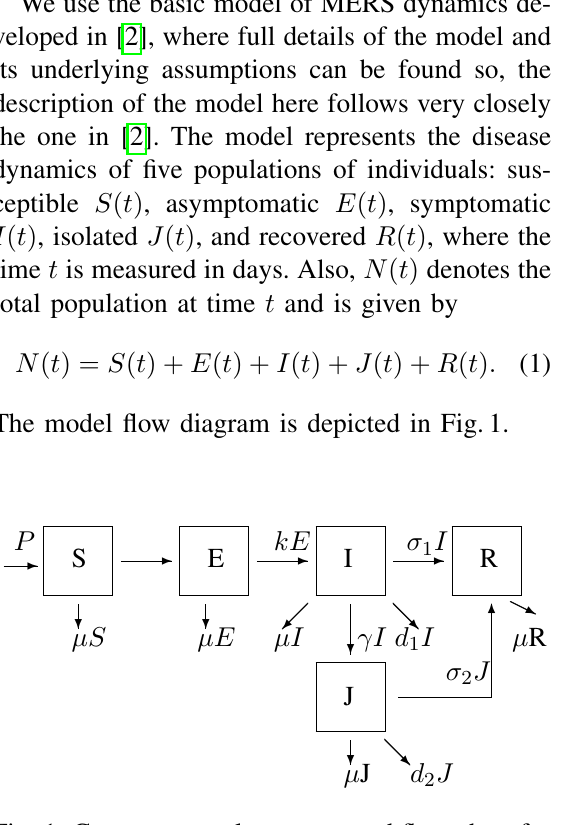
Fig. 1: Compartmental structure and flow chart